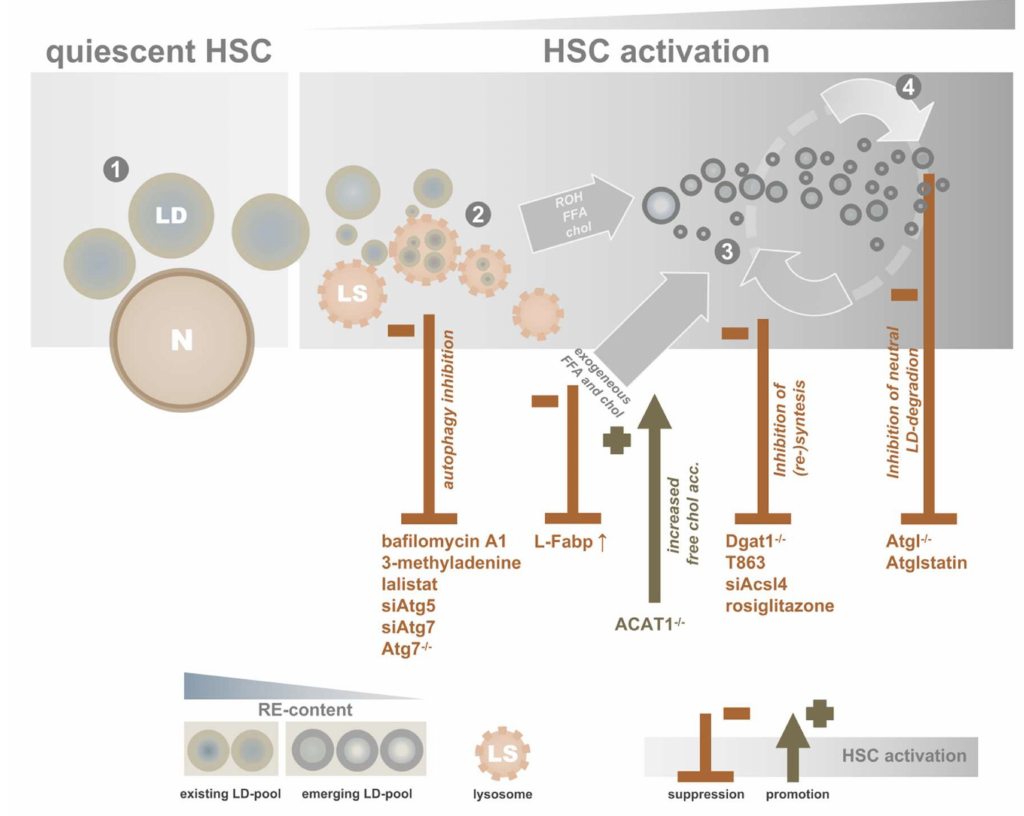
Figure 4. Lipid droplet homeostasis and HSC activation. Summary of targets and